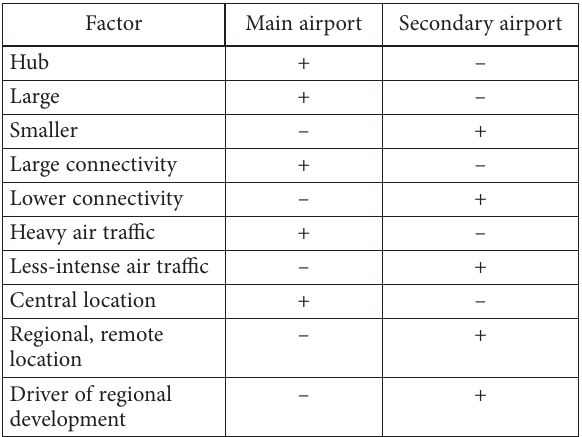
Table 5. Checklist of the key concept of the main and secondary airport (created by the authors)